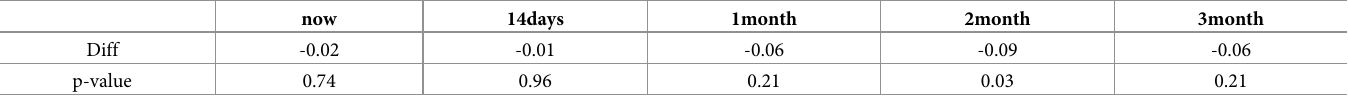
Table 2. Difference in fever recall (poor vs non-poor)—proportions test (2-tail & clustered by